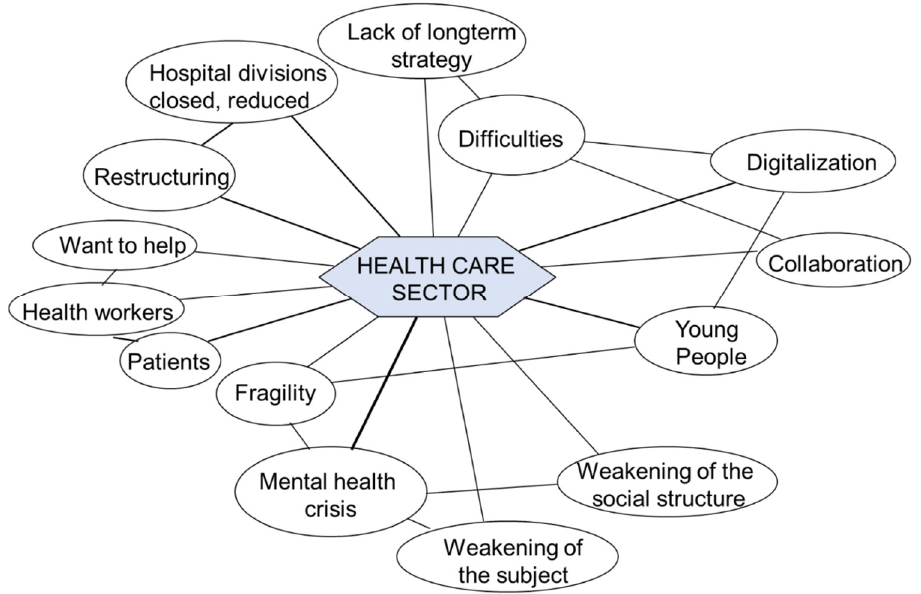
Figure 2. The healthcare sector in Merano (N = 14, expansion factor = 2).